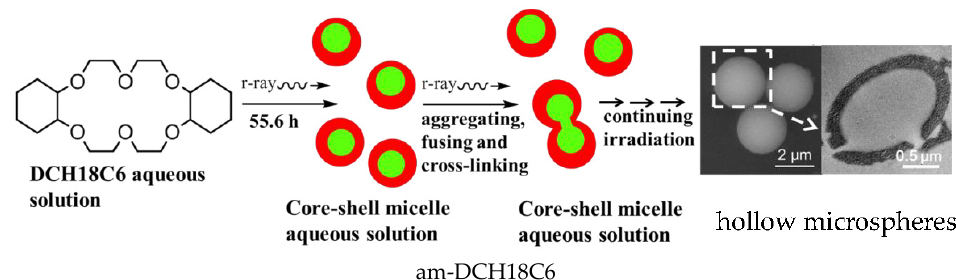
Scheme 1. Schematic representation for the synthesis of hollow microspheres from DCH18C6 via one-step γ -irradiation in